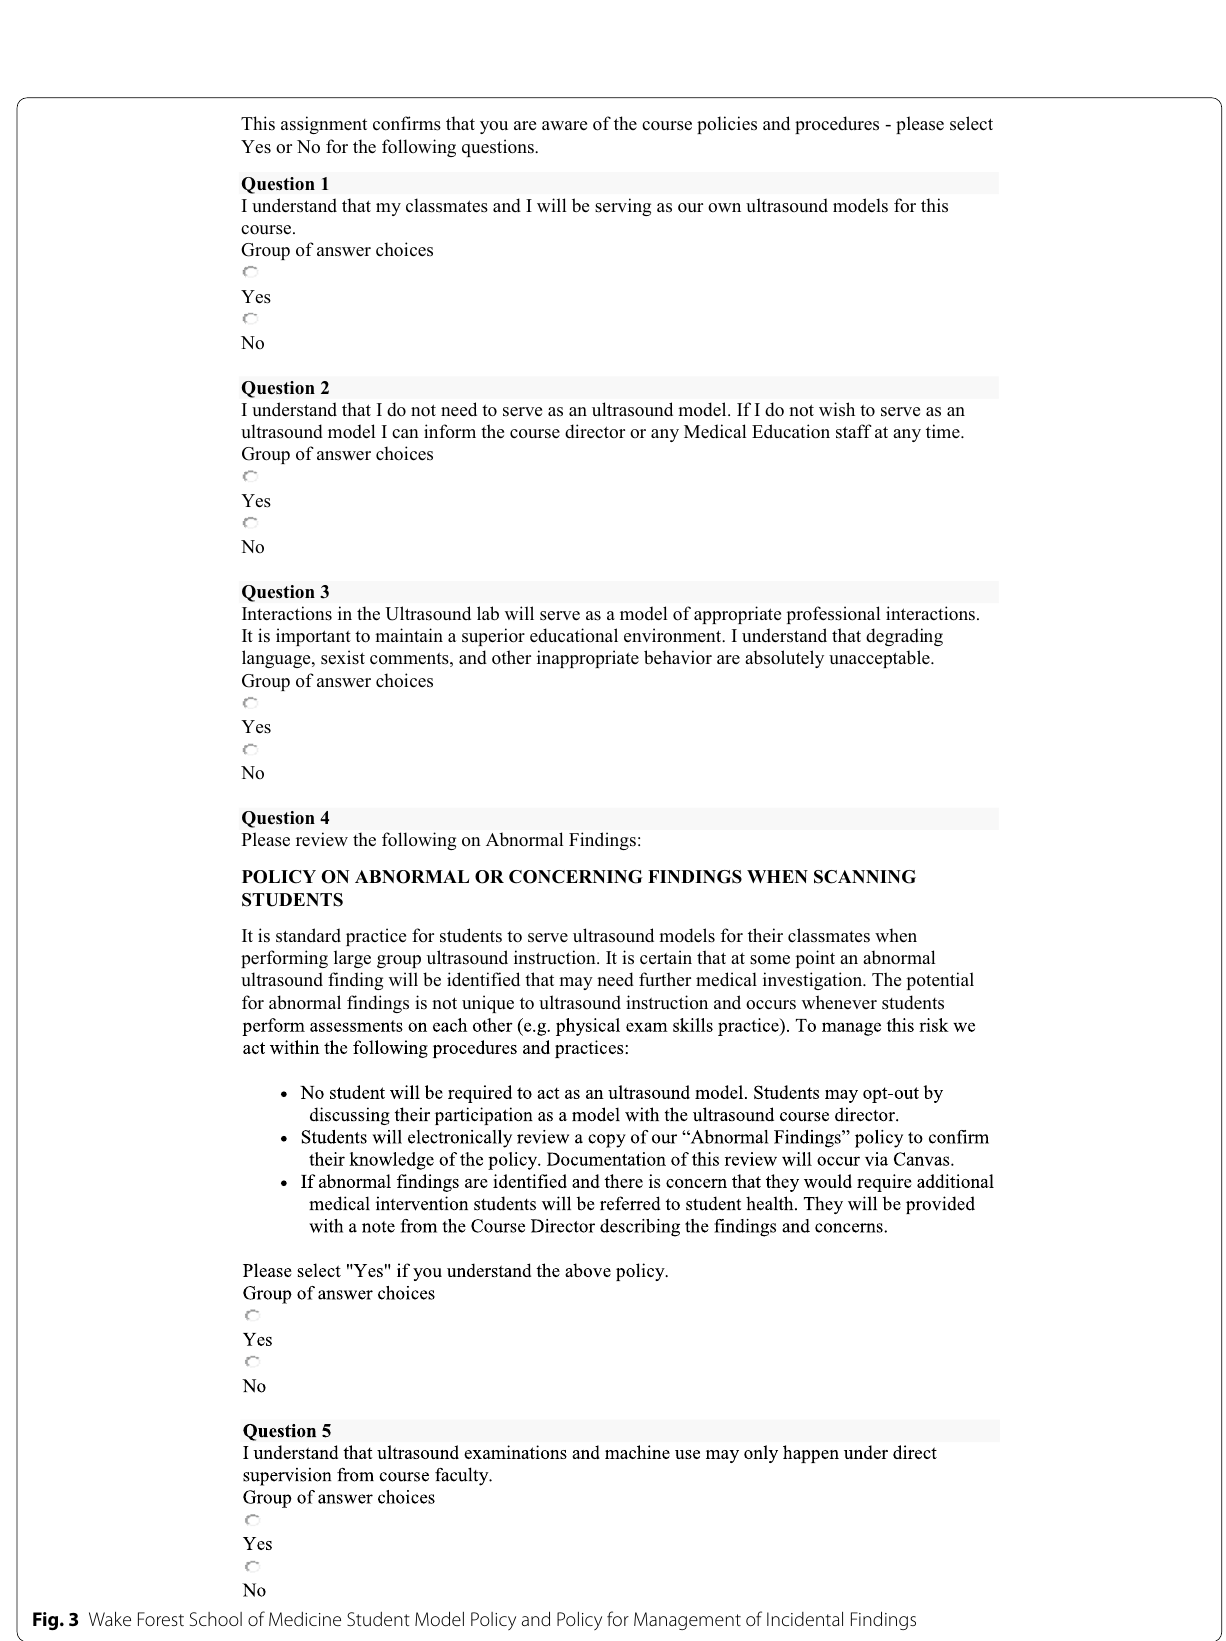
Fig. 3 Wake Forest School of Medicine Student Model Policy and Policy for Management of Incidental